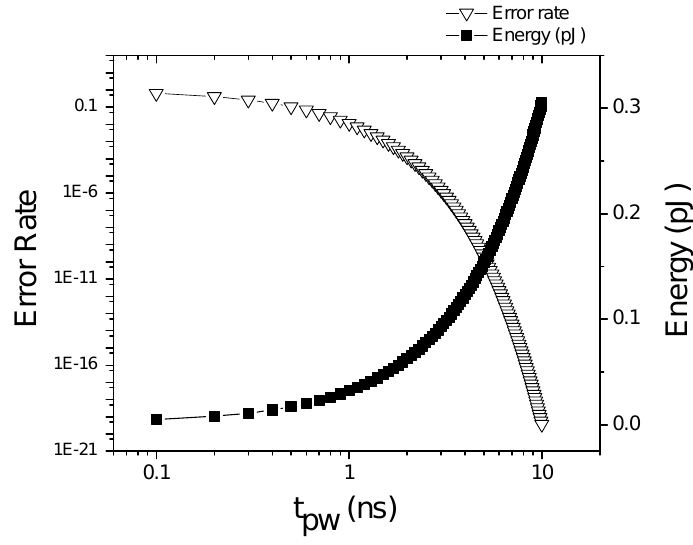
Figure 6. Error rate and the expected energy of the proposed NVFF at different write pulse